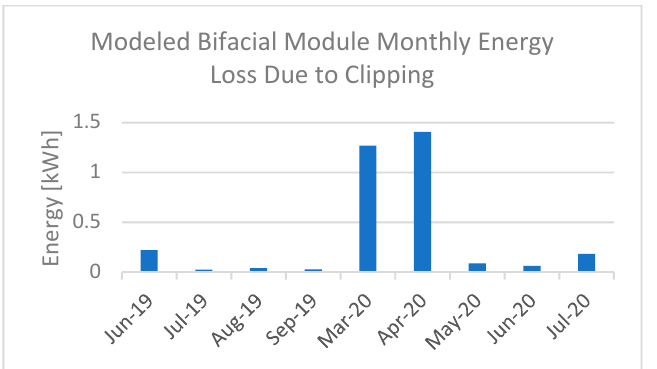
Figure 6. Calculated energy loss from clipping from one south-facing bifacial module.